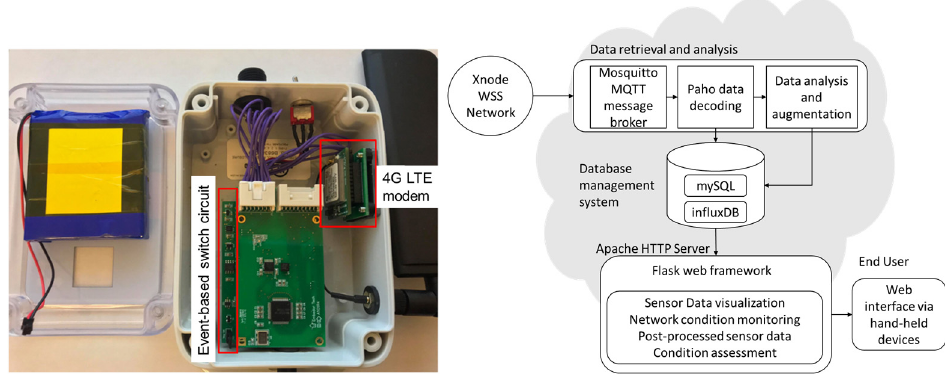
Figure 5. Cloud-based data management: hardware setup and framework overview [19].